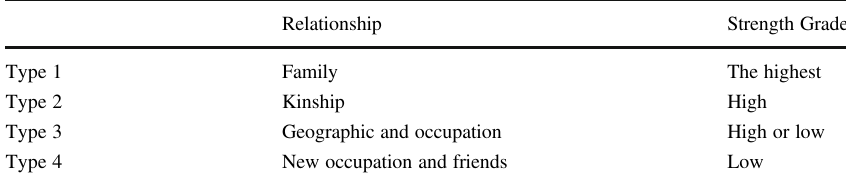
Table 1 Migrate minority groups ’ social relationship network